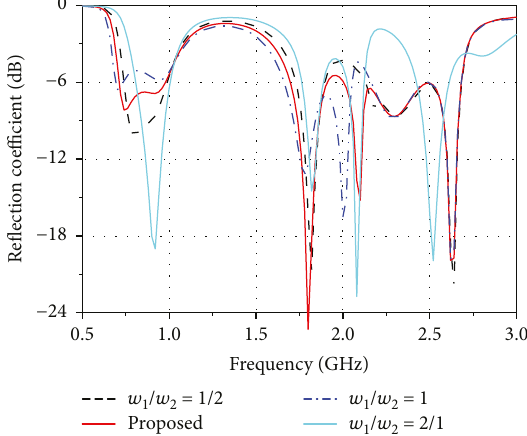
/ w on re fl ection coe ffi 1 2